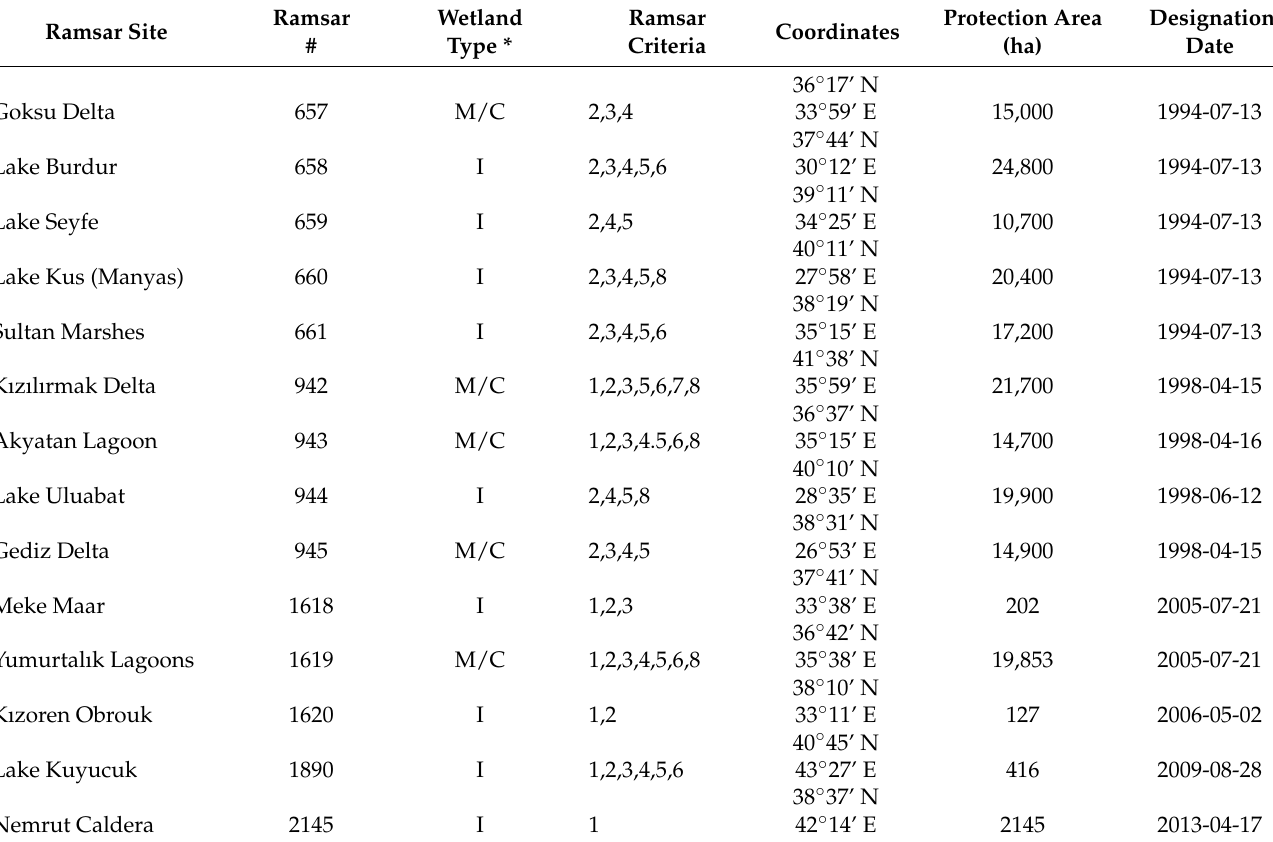
Figure 1. Turkey’s Ramsar sites and nearby meteorological stations. Table 2. Ramsar sites of